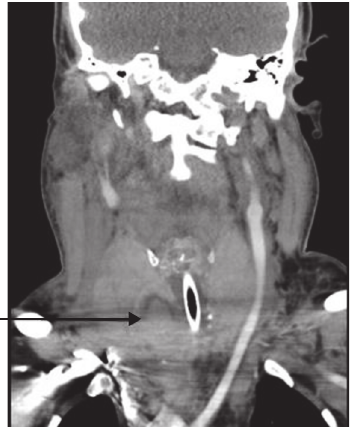
Figure 2: Arterial phase CT neck: coronal view of neck haematoma demonstrating lateral displacement of the great vessels and trachea and hyperdense haemorrhage within right-sided thyroid nodule (arrow).